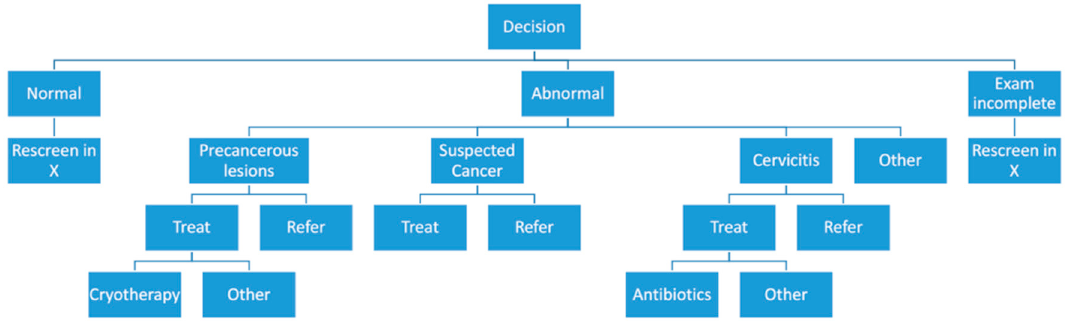
Figure 4. A schematic of the decision support job aid.